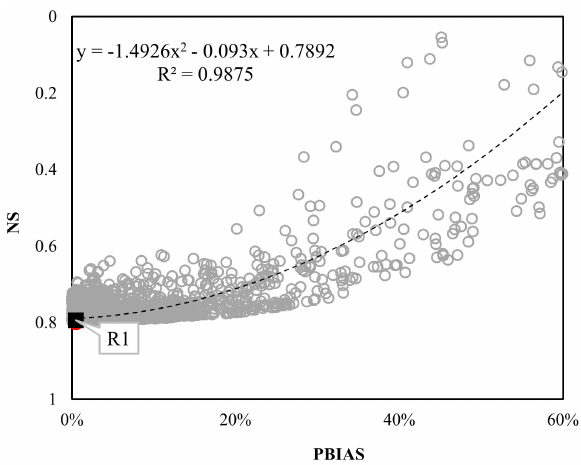
Figure 6. Solution distribution in objective space of Nash–Sutcliffe efficiency coefficient ( NS ) and percentage estimation bias ( PBIAS ) of runoff obtained by single objective